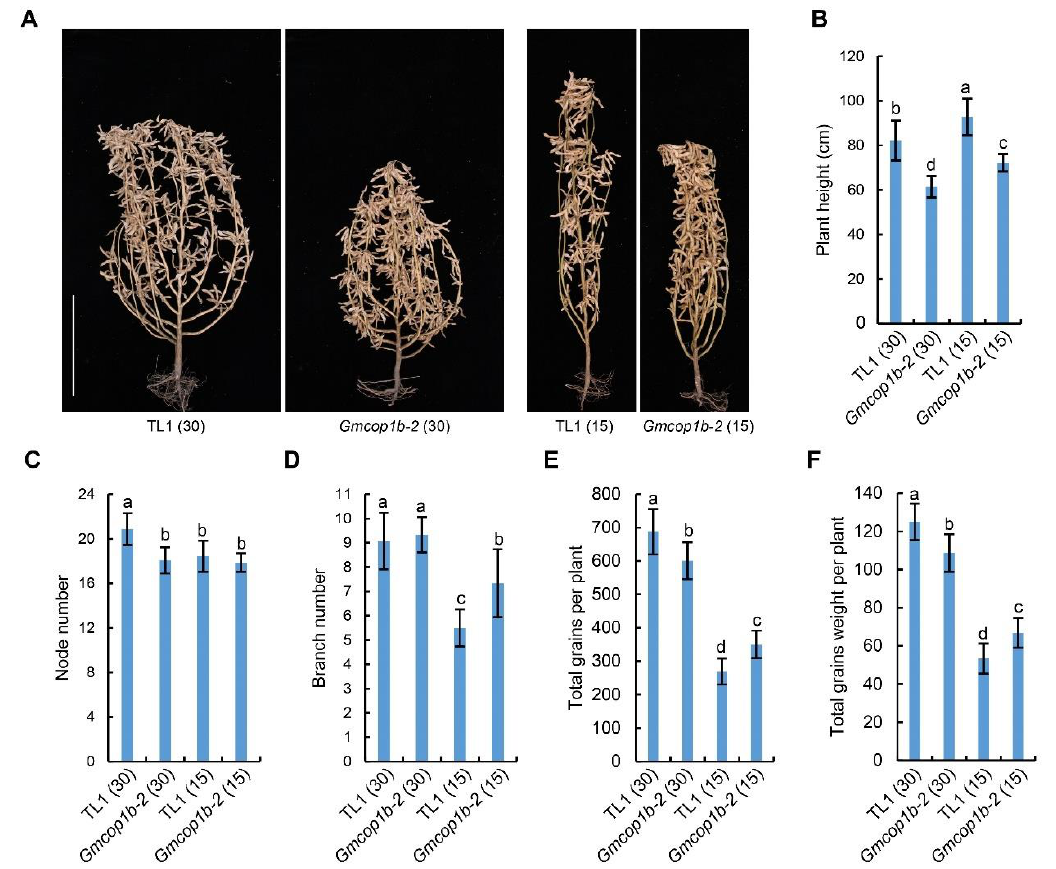
Figure 6. Agronomic traits of the Gmcop1b-2 mutant and TL1 under different planting densities in the field. ( A ) Representative images of the indicated lines grown with a plant spacing of 30 cm or 15 cm at the R8 stage. Scale bar = 30 cm. ( B – F ) Statistical analysis of plant height ( B ), node number ( C ), branch number ( D ), total grains per plant ( E ), and total grains weight per plant ( F ) of the lines in ( A ). The lowercase letters indicate significant differences as determined by two-way ANOVA with Tukey’s post hoc test ( p < 0.01). Numbers in the brackets indicate the plant spacing, and the unit is cm.